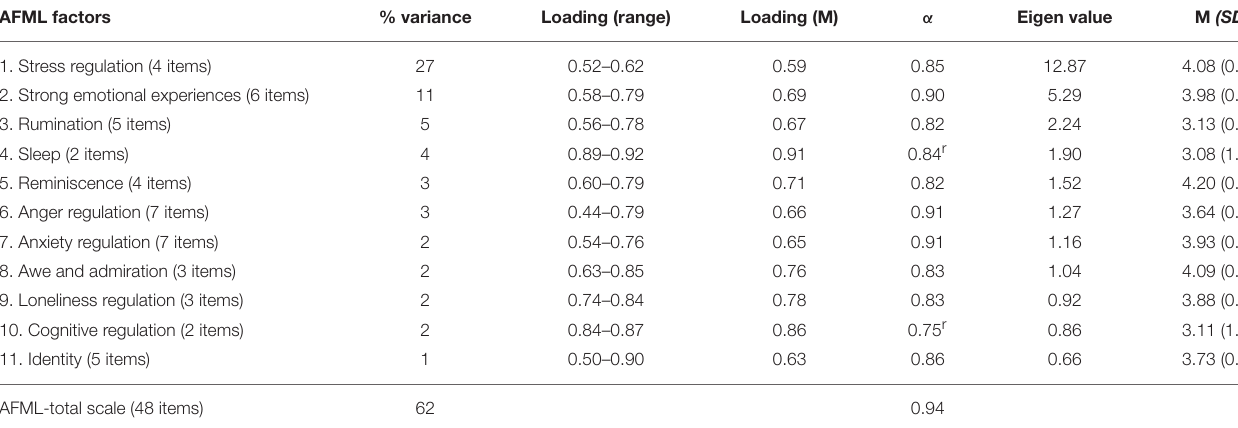
TABLE 3 | Results of EFA and psychometric properties of 11 factors of the AFML scale. AFML